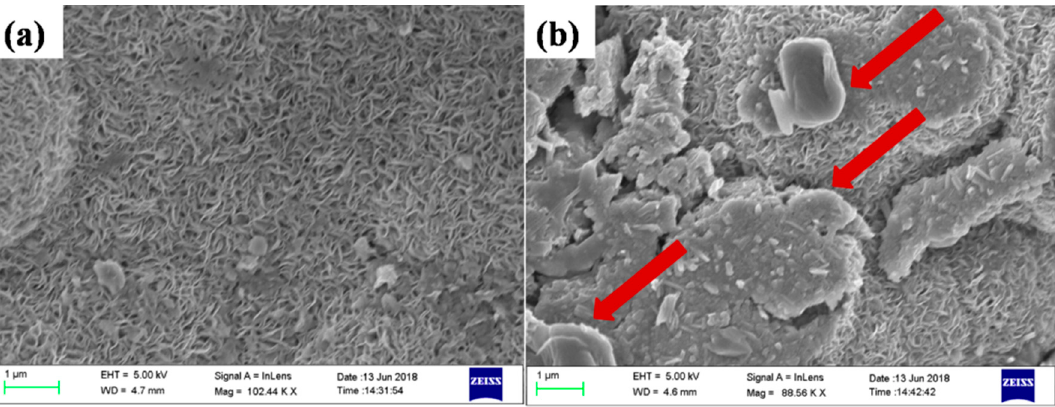
Figure 3. Field emission scanning electron microscopy (FE-SEM) micrographs of ( a ) pristine MoS 2 ( b ) and CTAB–MoS 2 .